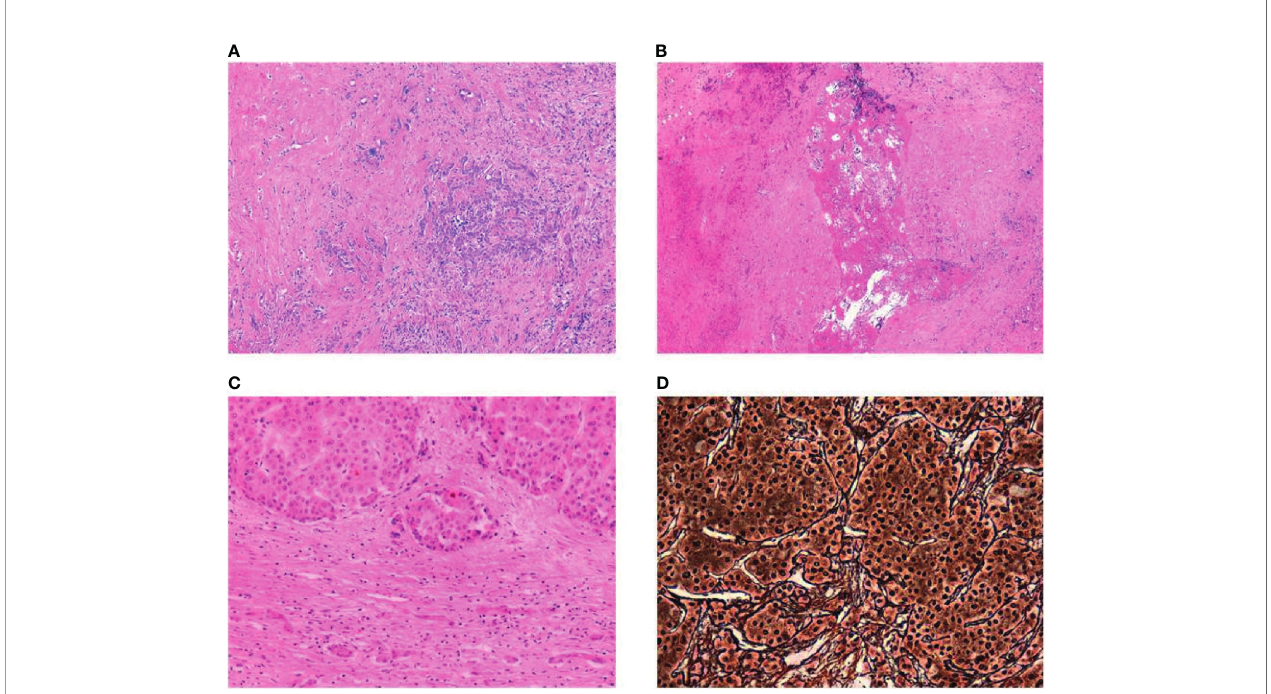
FIGURE 2 | (A) Ductular proliferation and lymphocytic in fl ammation at the sclerotic border of a completely regressed HCC (H&E, magni fi cation 50×), (B) Central necrosis with surrounding scarring fi brous tissue, no vital residual tumor analogous to Dworak regression score of IV (H&E, magni fi cation 50×), (C) Residual HCC with dense fi brous capsule (H&E, magni fi cation 100×), (D) Reticulin staining showing loss of the reticulin meshwork and macrotrabecular architecture in HCC (Gomori ’ s Reticulin,